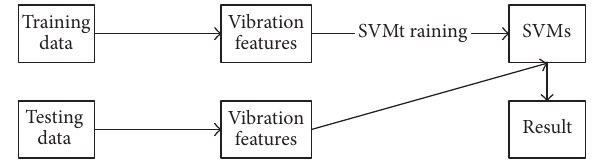
Figure 9: Flow chart of fault diagnosis using SVM.